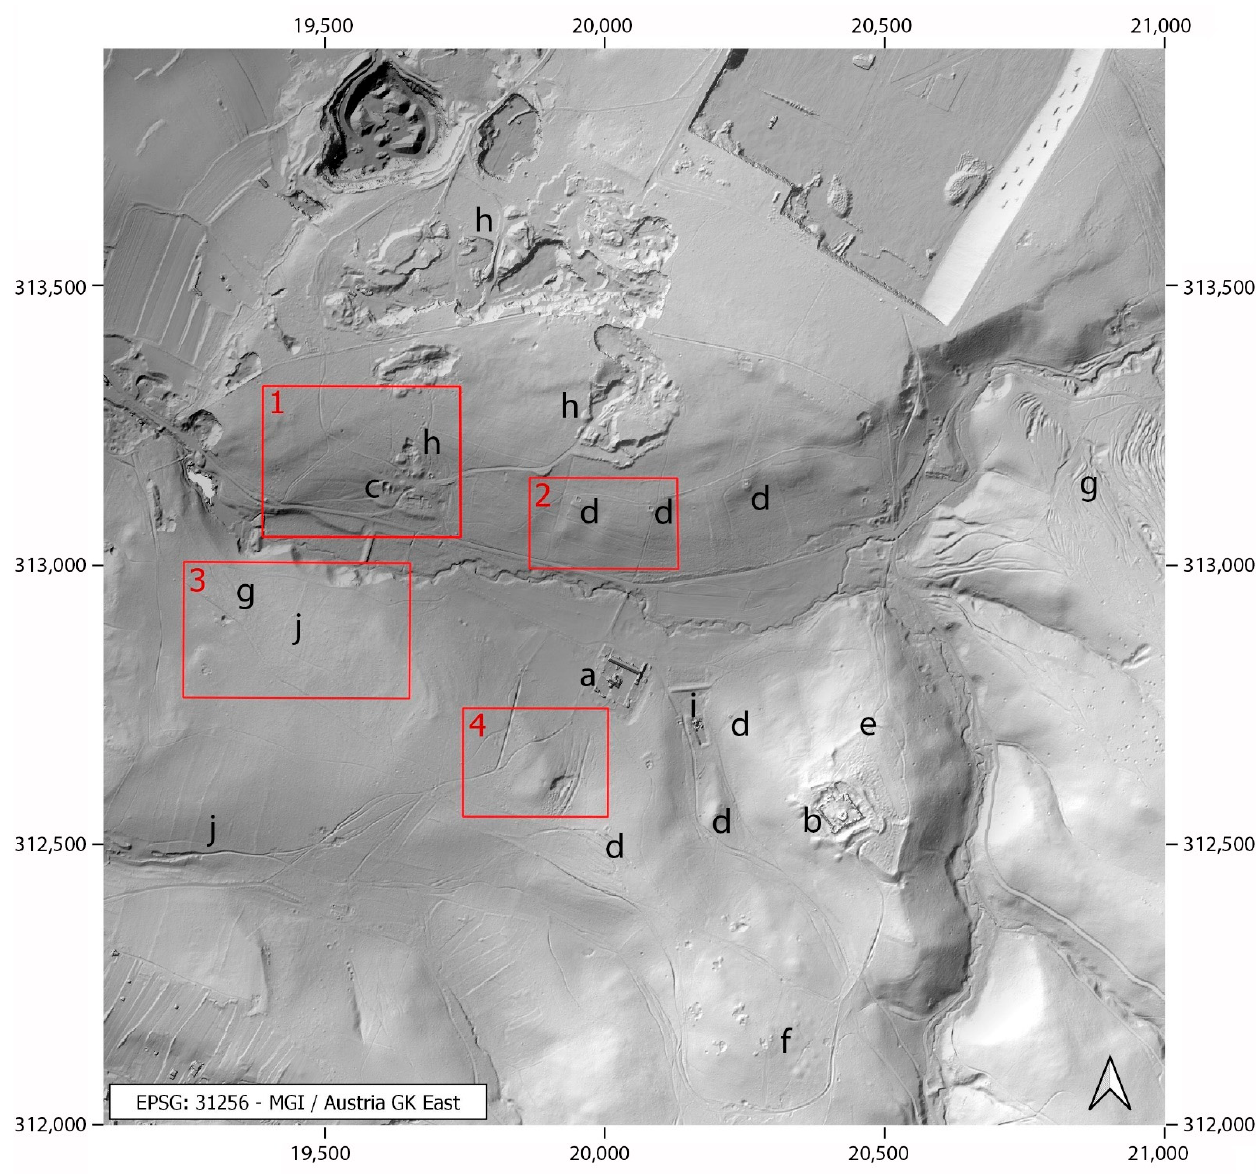
Figure 2. Various types of archaeological features located in the St. Anna area. Hillshade visualisa- tion of data acquired in Spring 2007. The red boxes indicate the location of sample zones fully in- terpreted archaeologically (1–4). ( a ) friary complex, ( b ) Castle of Scharfeneck, ( c ) former farmhouse, ( d ) hermit’s cells, ( e ) prehistoric hillfort, ( f ) barrows, ( g ) trackways, ( h ) quarries, ( i ) fishponds, ( j ) field system.